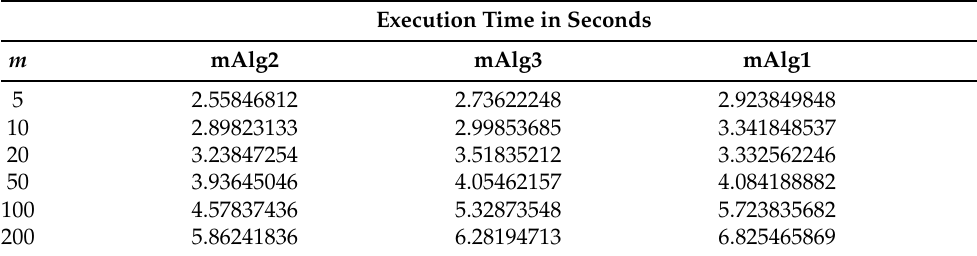
Table 1. Figures 1–6 execution time required for first 200 iterations.